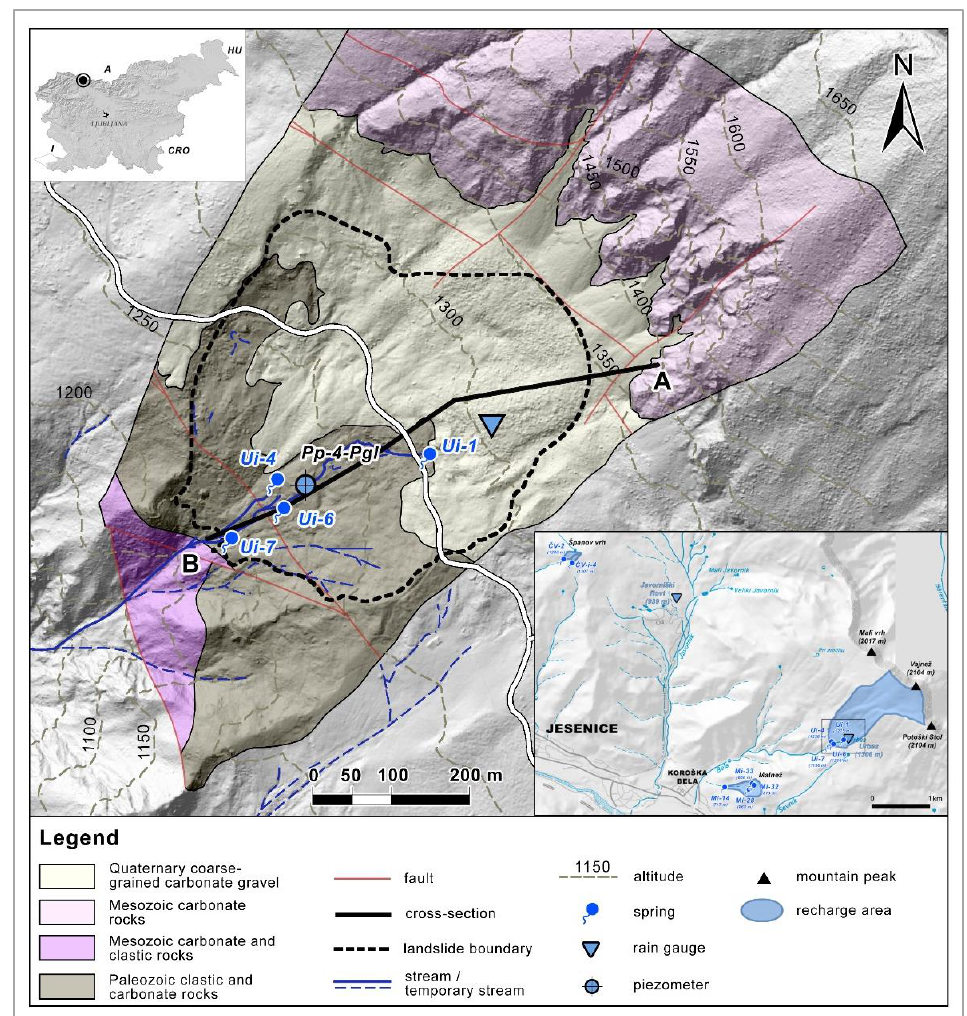
Figure 1. Geological map of the Urbas study area with landslide boundary (modified after [27] ), sampling points, and cross-section (Figure 2).